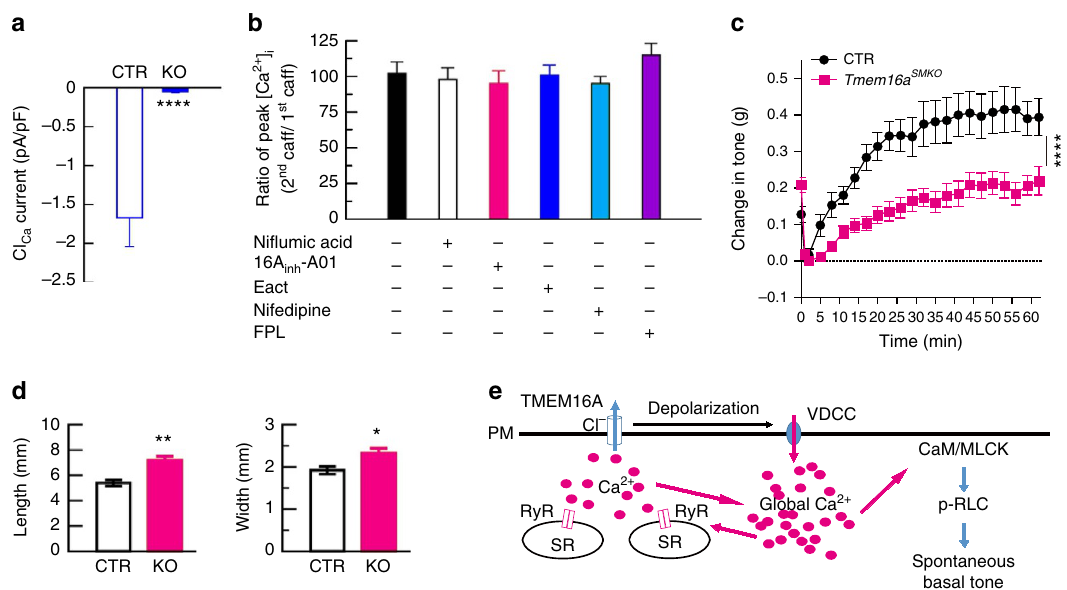
Figure 5 | TMEM16A deletion impairs IAS smooth muscle function and faecal defecation. ( a ) Caffeine (10mM)-induced Cl Ca currents at the holding potential of (cid:2) 70mV in IAS-SMCs from control and Tmem16a SMKO mice. **** P o 0.0001 KO versus CTR by two-tailed Student’s t -test, n ¼ 14 for CTR and n ¼ 12 for KO (An additional five cells did not generated detectable Cl Ca currents and were excluded in this calculation). ( b ) Effects of Cl Ca channel and L-type Ca 2 þ channel modulators on caffeine-induced Ca 2 þ rise in IAS-SMCs from Tmem16a SMKO mice. Experiments were carried out with a protocol as described in Fig. 4a. n ¼ 7–10 cells. ( c ) Basal tone in Tmem16a SMKO mice is significantly reduced compared with CTR mice. Bars represent mean ± s.e.m.,